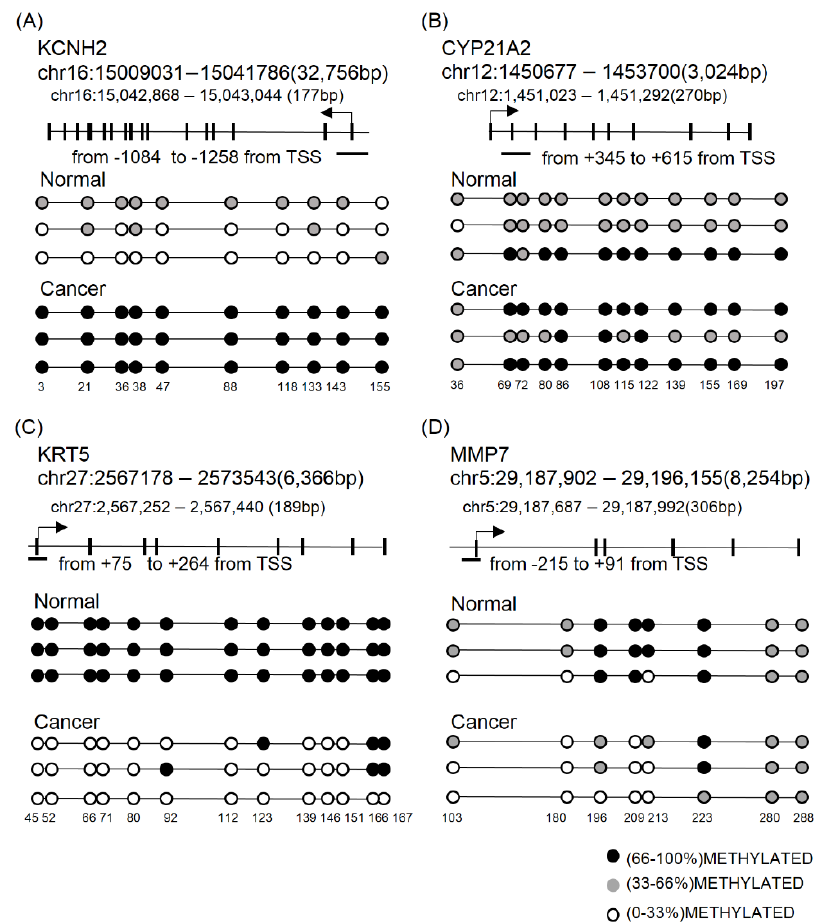
Figure 6. Validation of RRBS with targeted sequencing after BSC. ( A , B ) DMRs on the promoter region of four target genes was selected for validation. Various numbers of CpG sites on each promoter region are represented by a lollipop plot. KCNH2 ( A ) and CYP21A2 ( B ) genes were confirmed by cloning-based sequencing after BSC. Methylation states of each CpG site were measured by ratio of converted C to T after BSC PCR in five different clones. ( C,D ) Methylation on the promoter regions of KRT5 ( C ) and MMP7 ( D ) genes was measured by direct sequencing after BSC PCR. Signal density of C and T on each CpG site was calculated as methylation state and is depicted by color scale in three groups (66–100%: black, 33–66%: gray, and 0–33%: white). Bottom numbers indicate CpG loci based on transcription start site of gene. RRBS: reduced representative bisulfite sequencing; BSC: bisulfite conversion